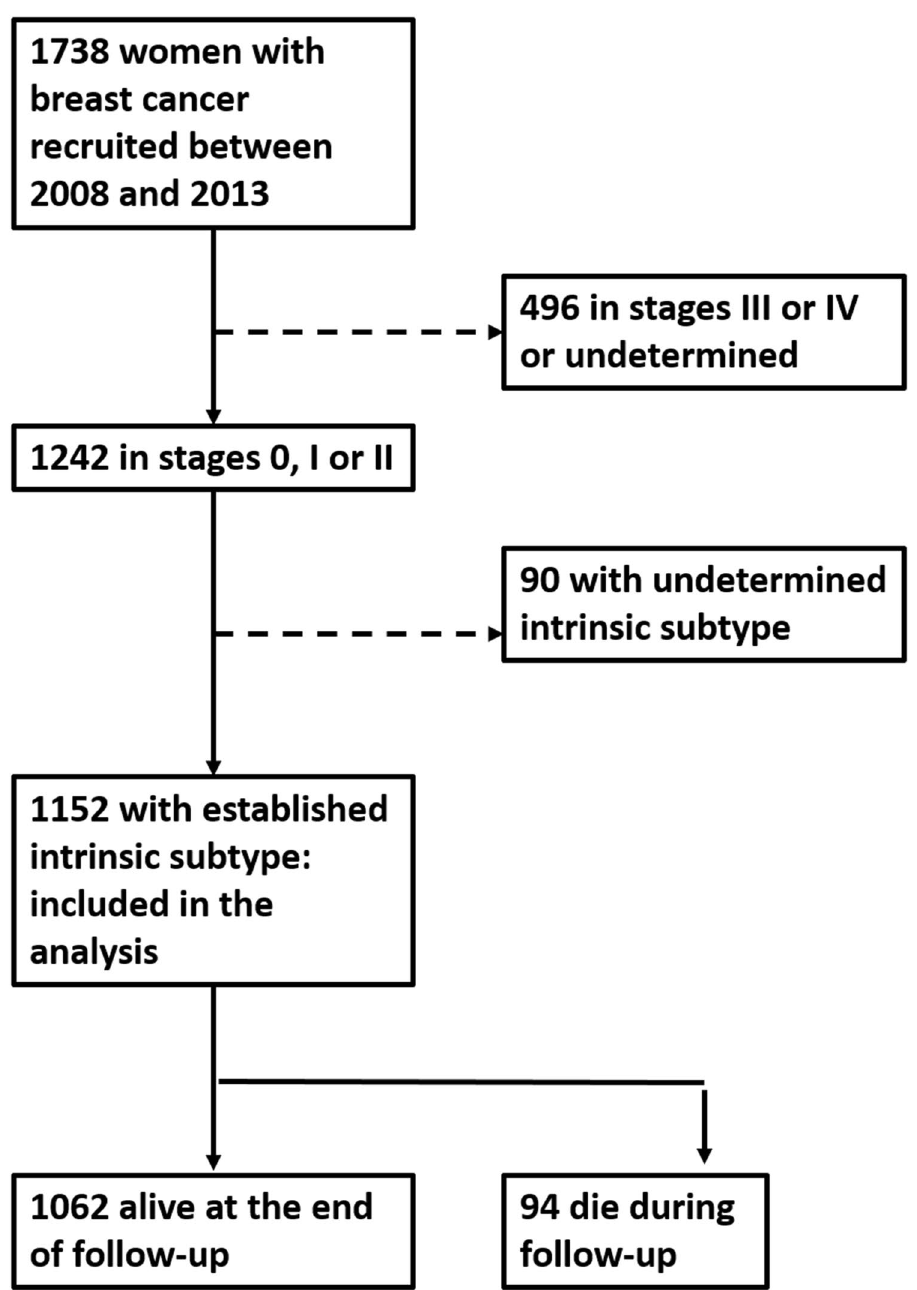
Figure 1. Flow chart of patients in this study. Solid arrows indicate patient selection. Dashed arrows indicate patient